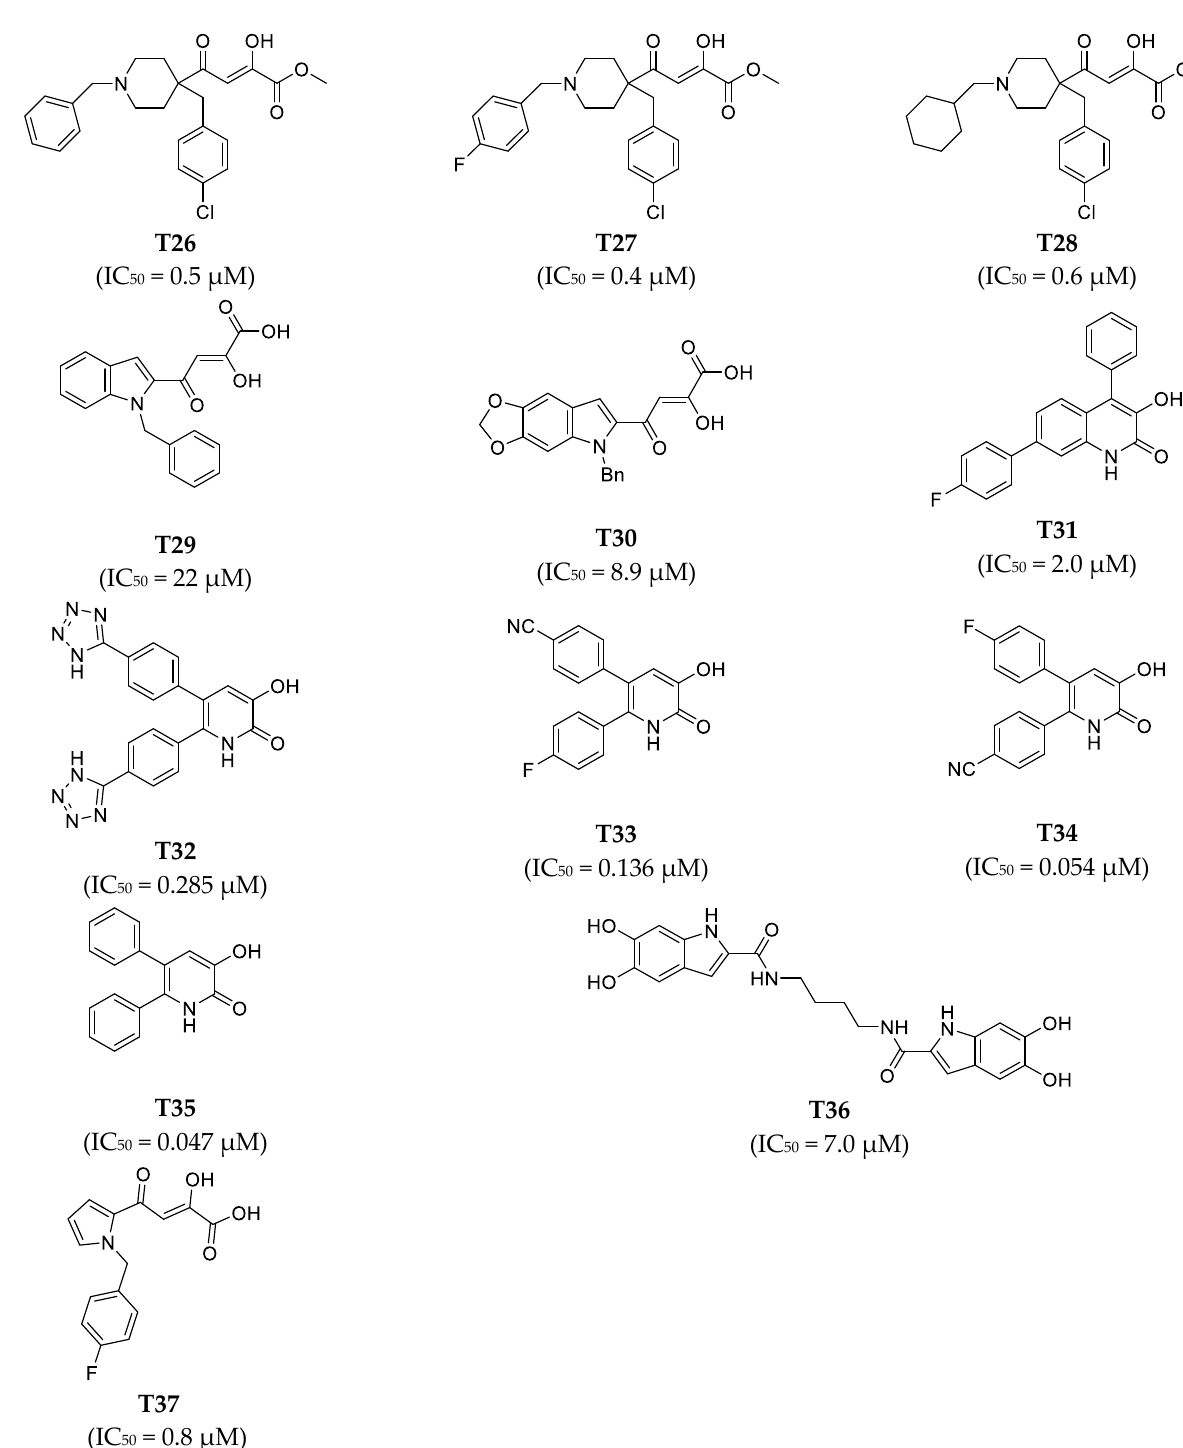
Figure 8. Chemical structures of PA N endonuclease inhibitors in the training set together with their biological activity data (IC 50 value, μM).